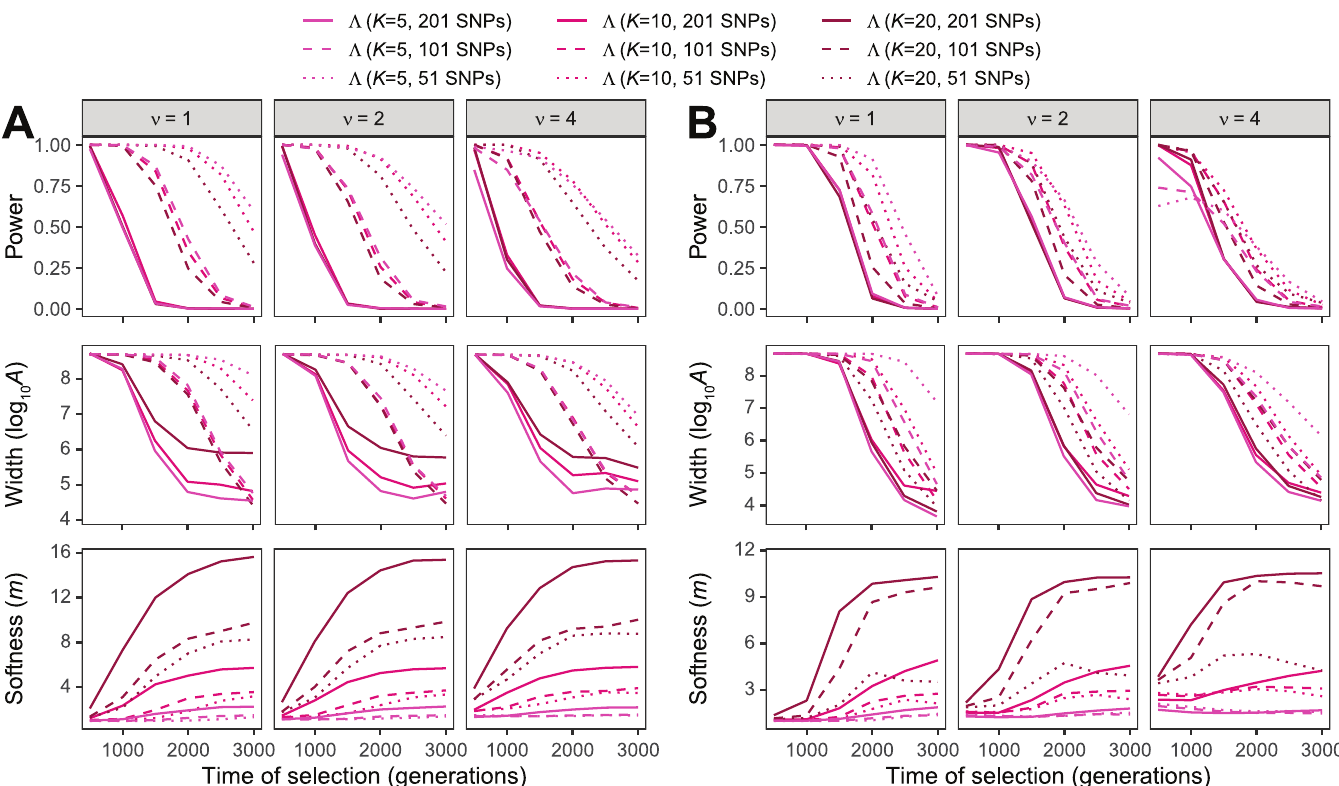
Fig 4. Performance of detecting and characterizing sweeps. Performance for applications of Λ with windows of size 51, 101, and 201 SNPs under simulations of (A) a constant-size demographic history or (B) the human central European (CEU) demographic history of [34] and the haplotype frequency spectra for the Λ statistic truncated at K 2 {5, 10, 20} haplotypes. Results are based on a sample of n = 50 diploid individuals. (Top row) Power at a 1% false positive rate as a function of selection start time. (Middle row) Estimated sweep width illustrated by mean estimated genomic size influenced by the sweep ( log (Bottom row) Estimated sweep softness illustrated by mean estimated number of sweeping haplotypes ( ^ m ) as a function of selection start time. Sweep scenarios consist of hard ( ν = 1) and soft ( ν 2 {2, 4}) sweeps with per-generation selection coefficient of s = 0.1 that started at t 2 {500, 1000, 1500, 2000, 2500, 3000} generations prior to sampling. Results expanded across wider range of simulation settings can be found in S32–S34 and S38–S40 Figs as well as results for application to unphased multilocus genotype data in S35–S37 and S41–S43